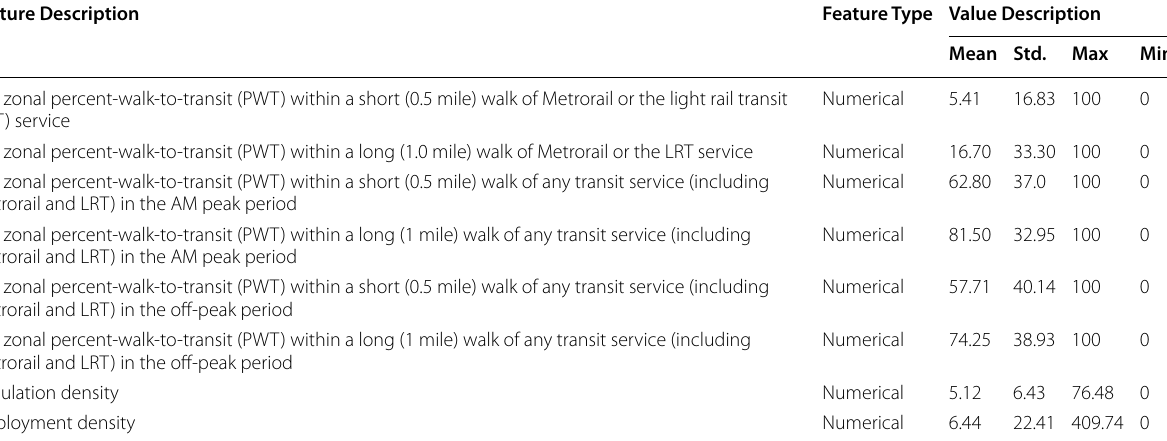
Table 1 Location and TAZ-related features Feature